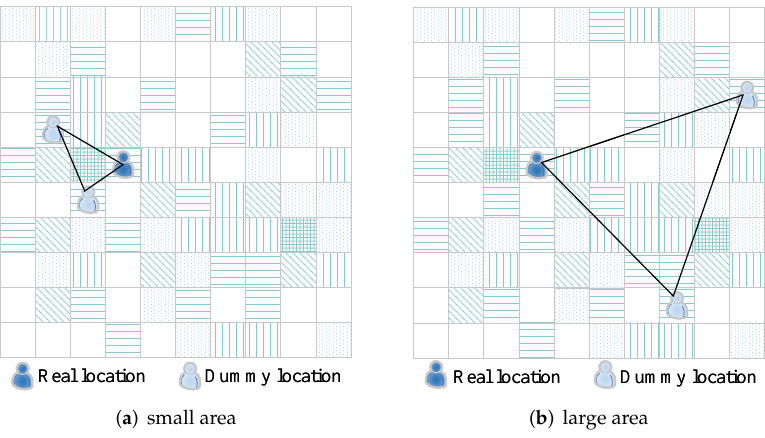
Figure 7. The physical dispersion situation between dummies and the real